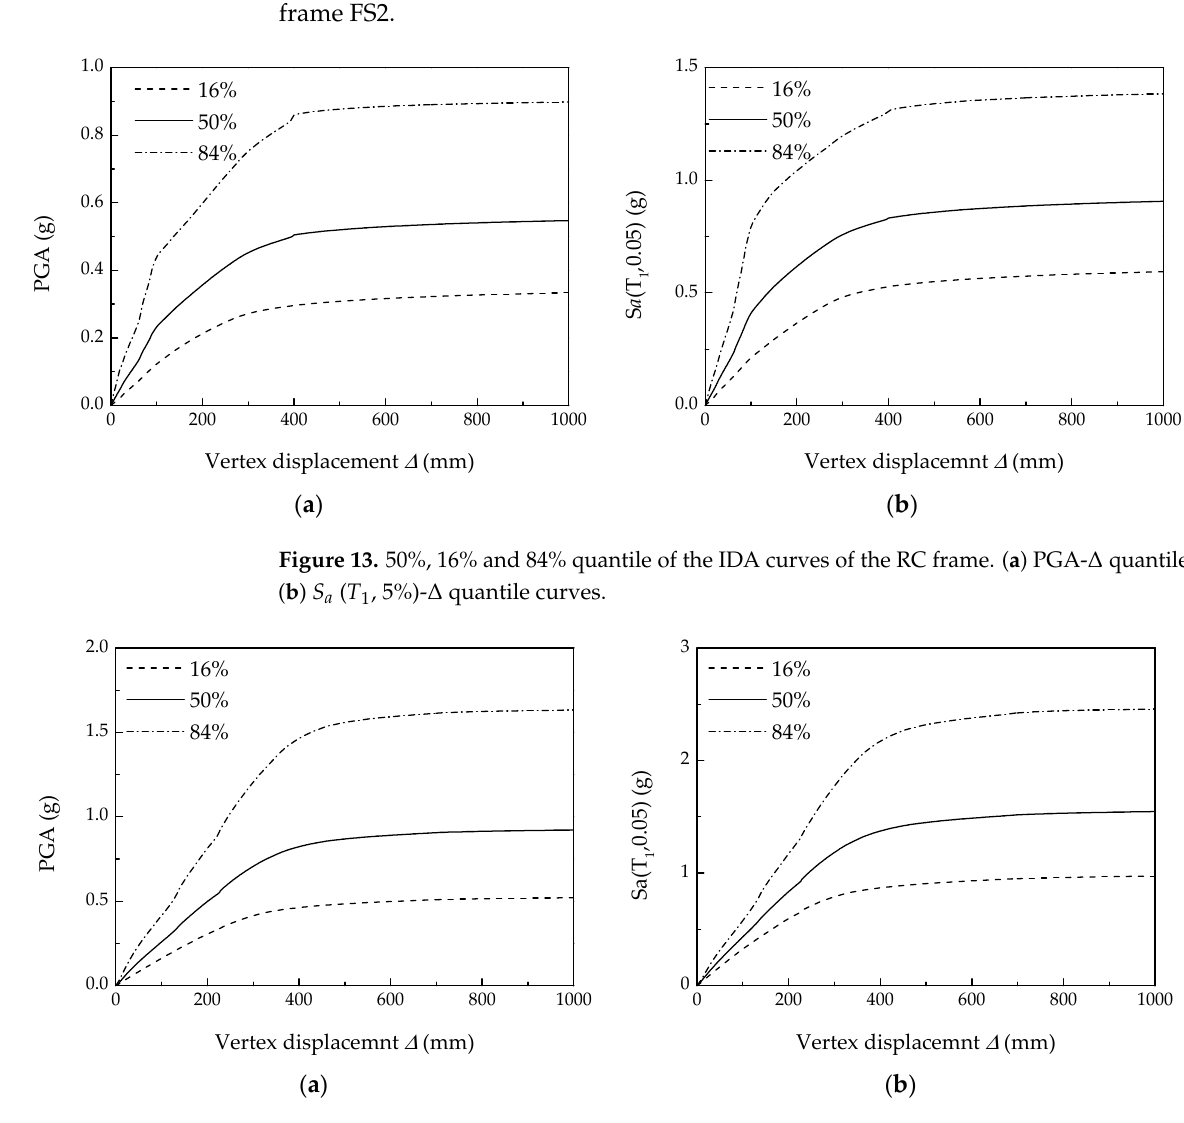
Figure 14. 50%, 16% and 84% quantile of the IDA curves of the ECC frame. (a)PGA- Δ quantile curves; (b) S a ( T 1, 5%)- Δ quantile curves.